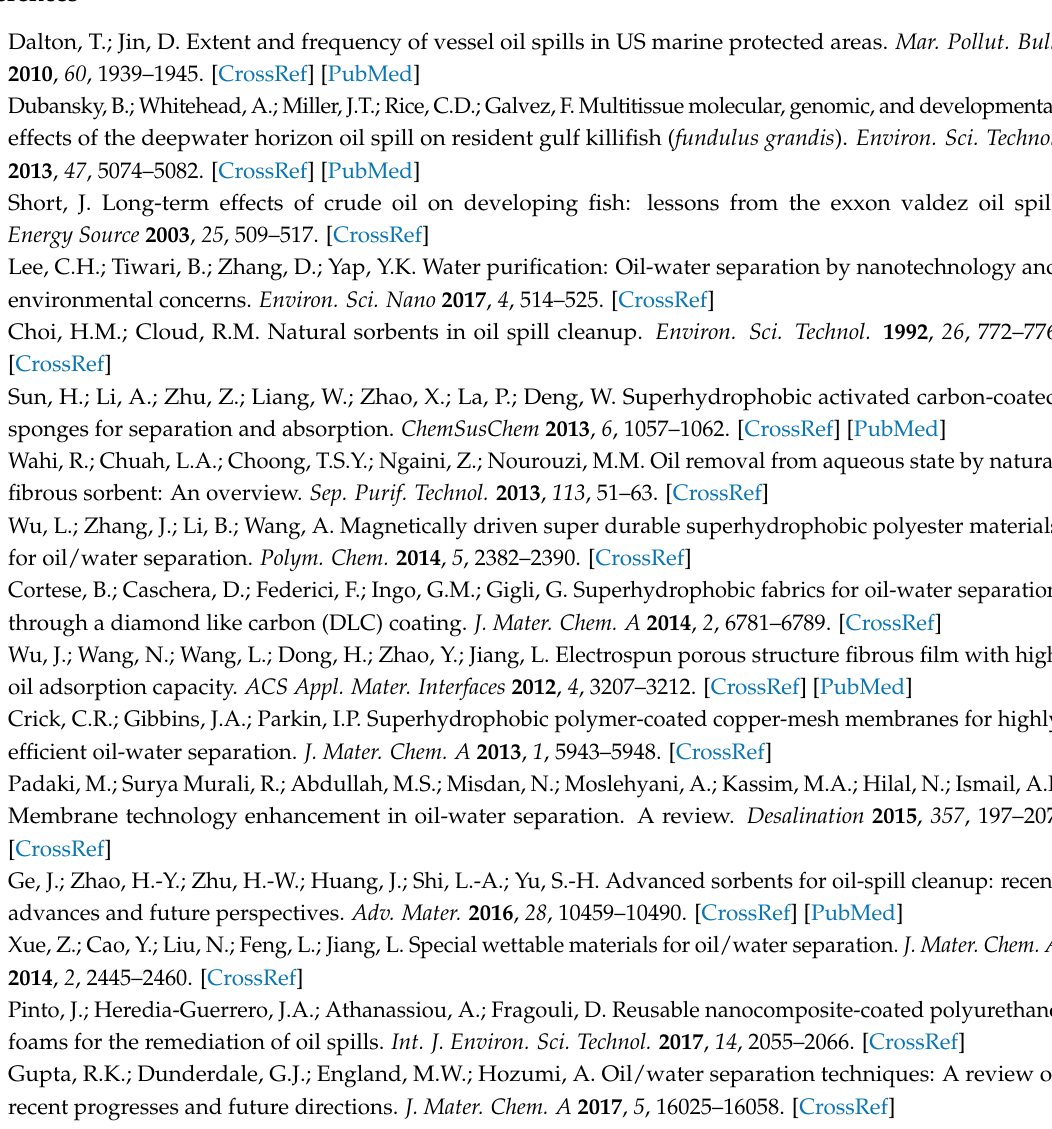
Figure S1: SEM images and FTIR spectra of the pristine PVA foam, PVA foam modified with SA and the Janus foam motor loaded with camphor; Figure S2: Trajectories of a typical Janus foam motor and an SA-PVA foam in 10 min; Figure S3: The contact angle of water on the surface of the SA end of the Janus foam motor; Figure S4: The oil/water separation by the Janus foam motor; Video S1: Self-propulsion of a Janus foam motor on water; Video S2: On-the-fly Oil capture and absorption by a Janus foam motor; Video S3: Oil capture and absorption by a Janus foam motor and an immobile SA-PVA foam; Video S4: Self-assembly of Janus foam motors; Video S5: Self-assembly process of two SA-PVA foams before and after oil